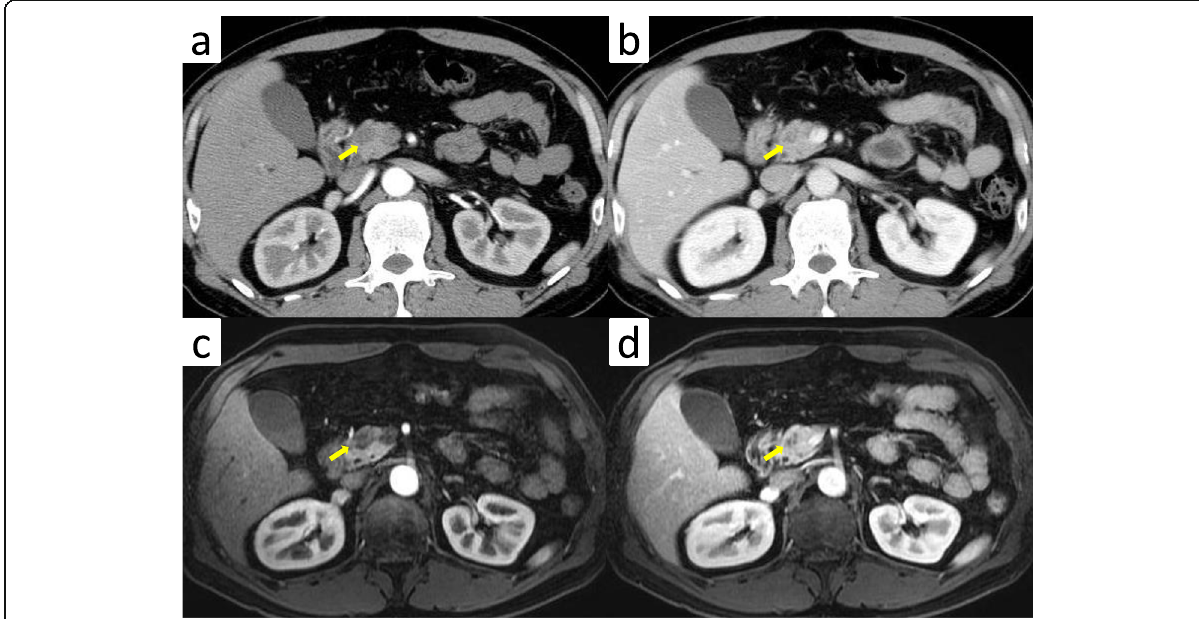
Fig. 1 Contrast-enhanced CT and Gd-EOB-DPTA – enhanced MRI revealed a nodule that was gradually contrasted in the pancreatic head (arrow). a Arterial phase of CT. b Portal phase of CT. c Early phase of MRI. d Late phase of MRI. CT, computed tomography; Gd-EOB-DPTA, gadolinium-ethoxybenzyl-diethylenetriamine; MRI, magnetic resonance